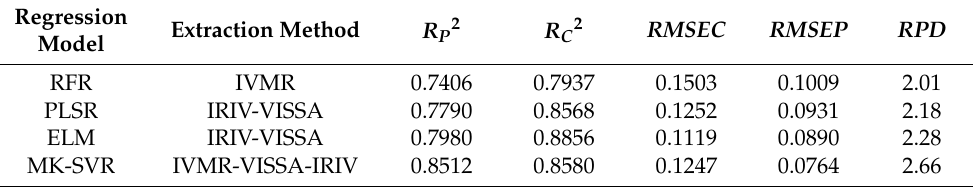
Table 9. Comparison of the optimal prediction results of four regression